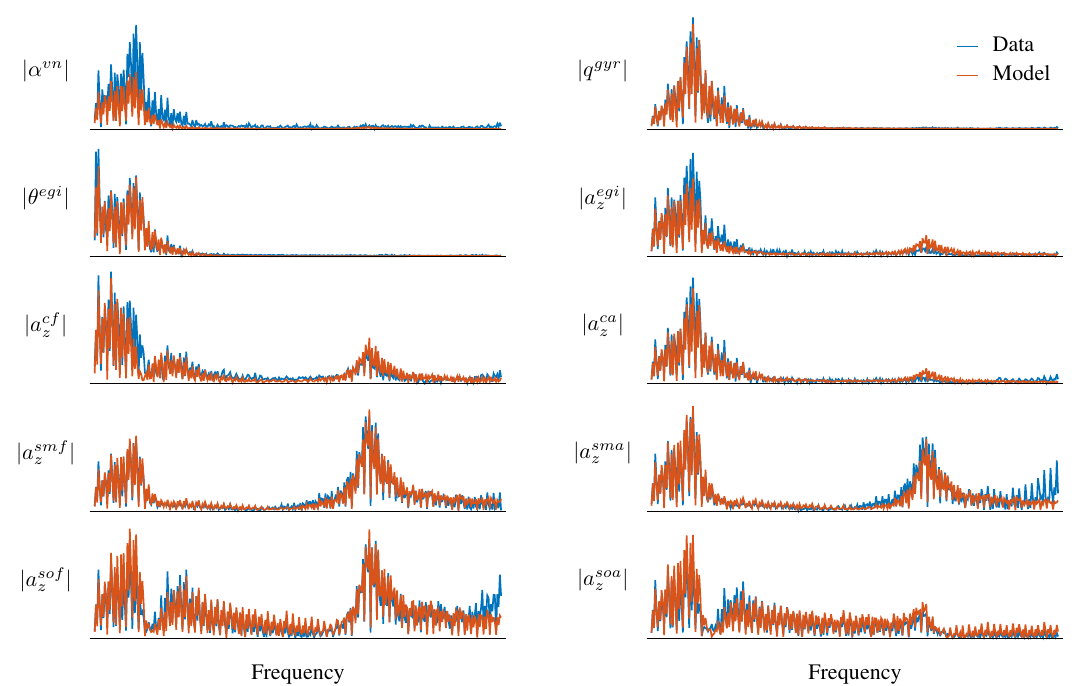
Figure 5. Model fits to Fourier transforms of measured outputs using output